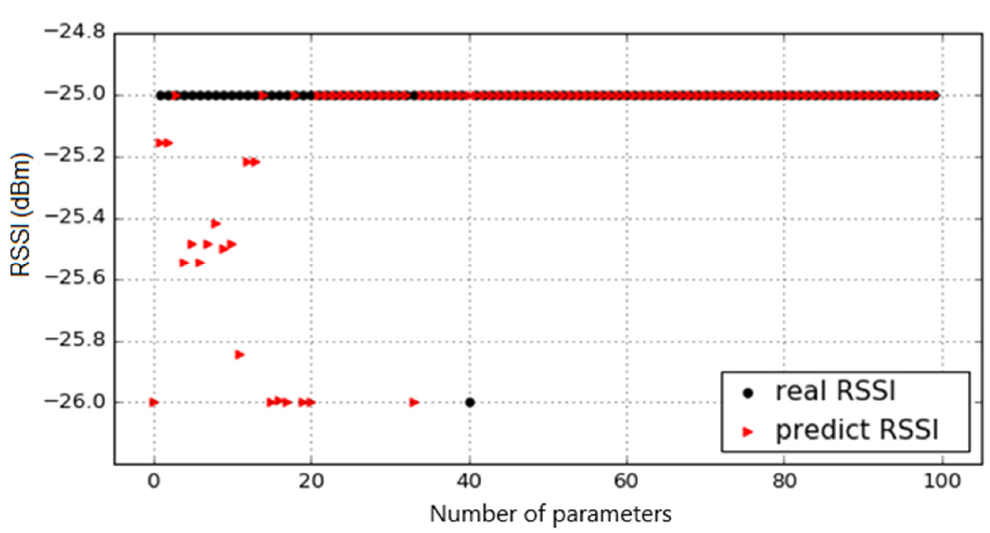
Figure 6. Example of prediction of the decision-tree regression method with AdaBoost regressor.